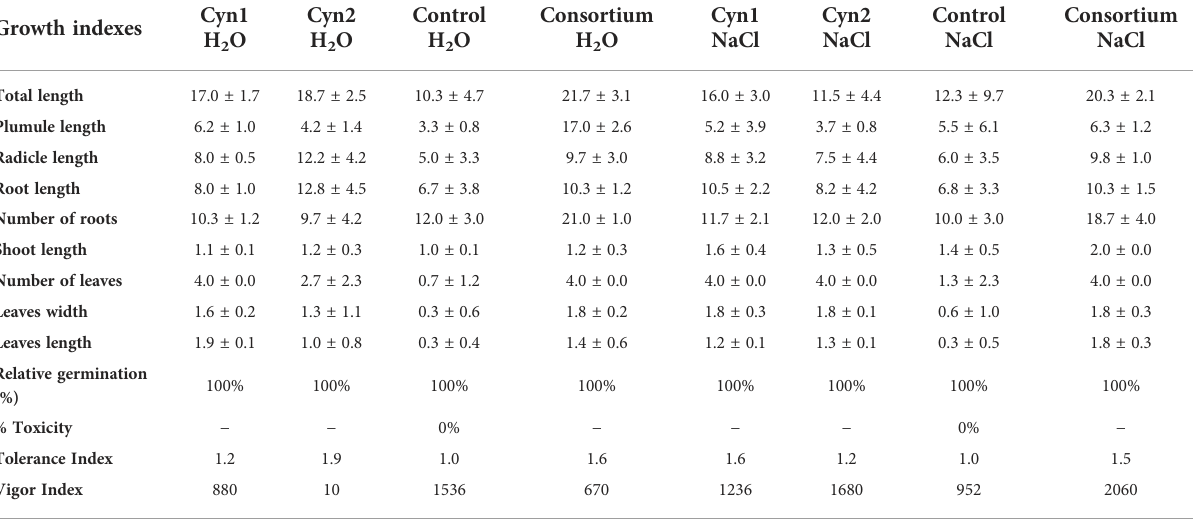
TABLE 2 Determination of plant growth indexes of Cyn1, Cyn2, and their consortium on P. vulgaris L. under salinity stress in comparison to control.